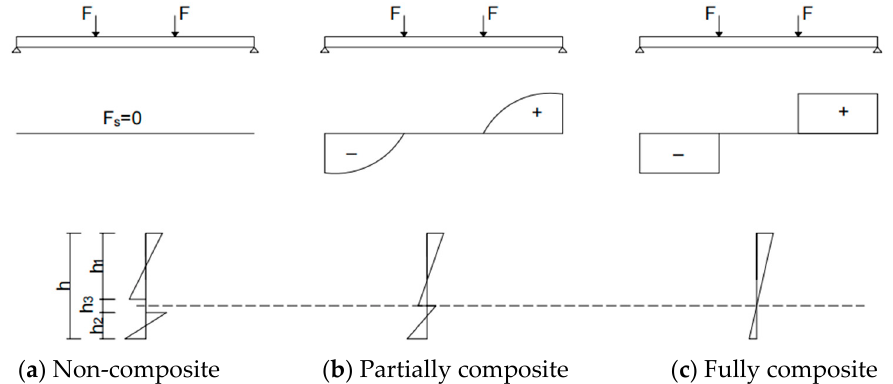
Figure 16. Distribution of shear force and strain.